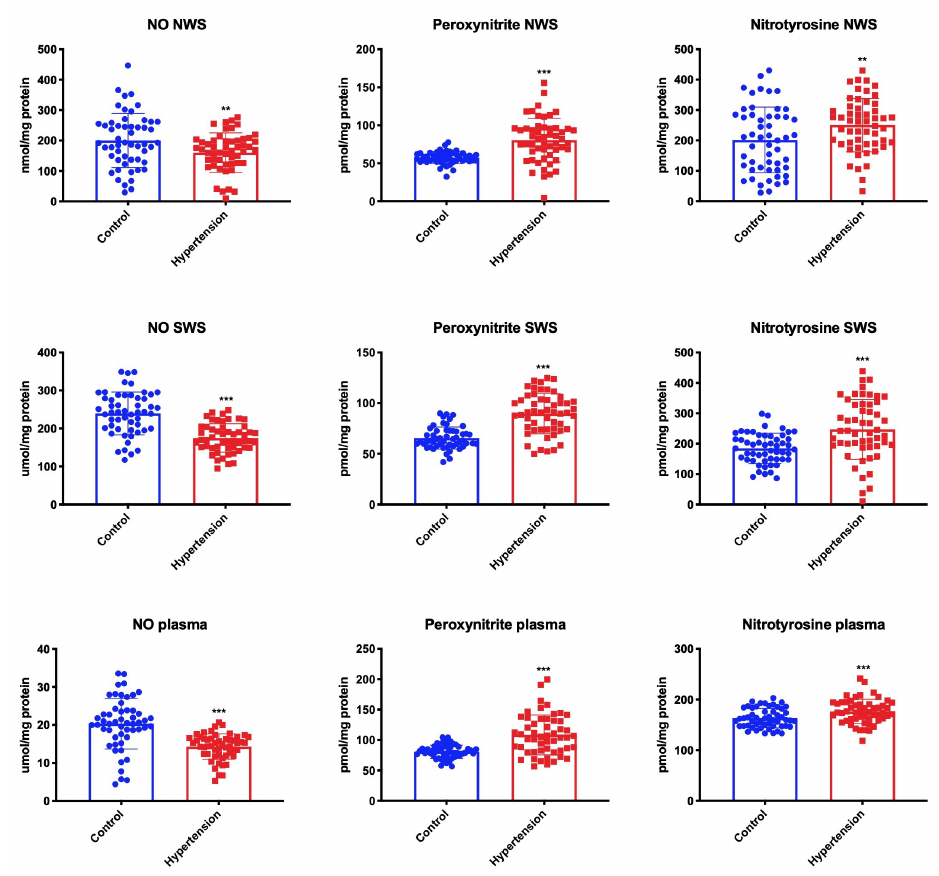
Figure 5. Nitrosative stress in children with hypertension and healthy controls. NO—nitric oxide; NWS—non-stimulated whole saliva; SWS—stimulated whole saliva. Differences statistically significant at: ** p < 0.01, *** p < 0.001 (Student’s t-test).